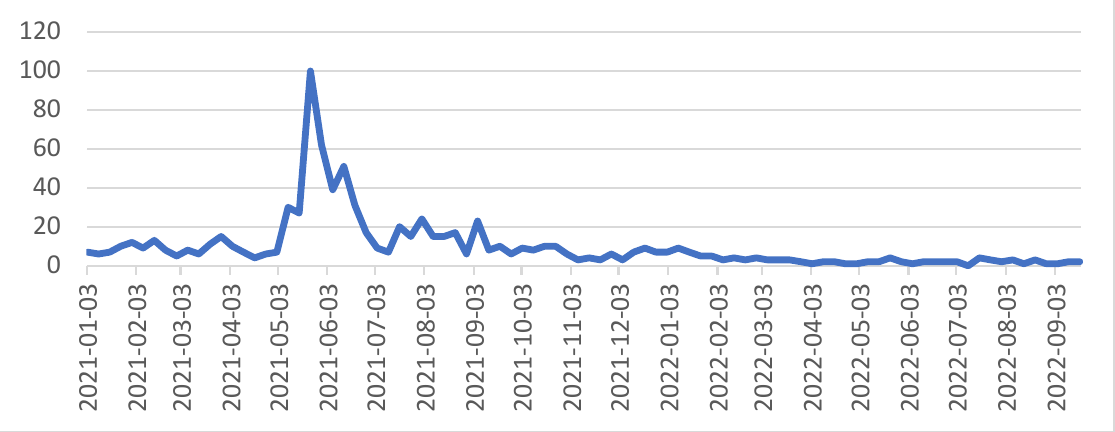
Figure 2. “Wuhan Lab” keywords Google trends.